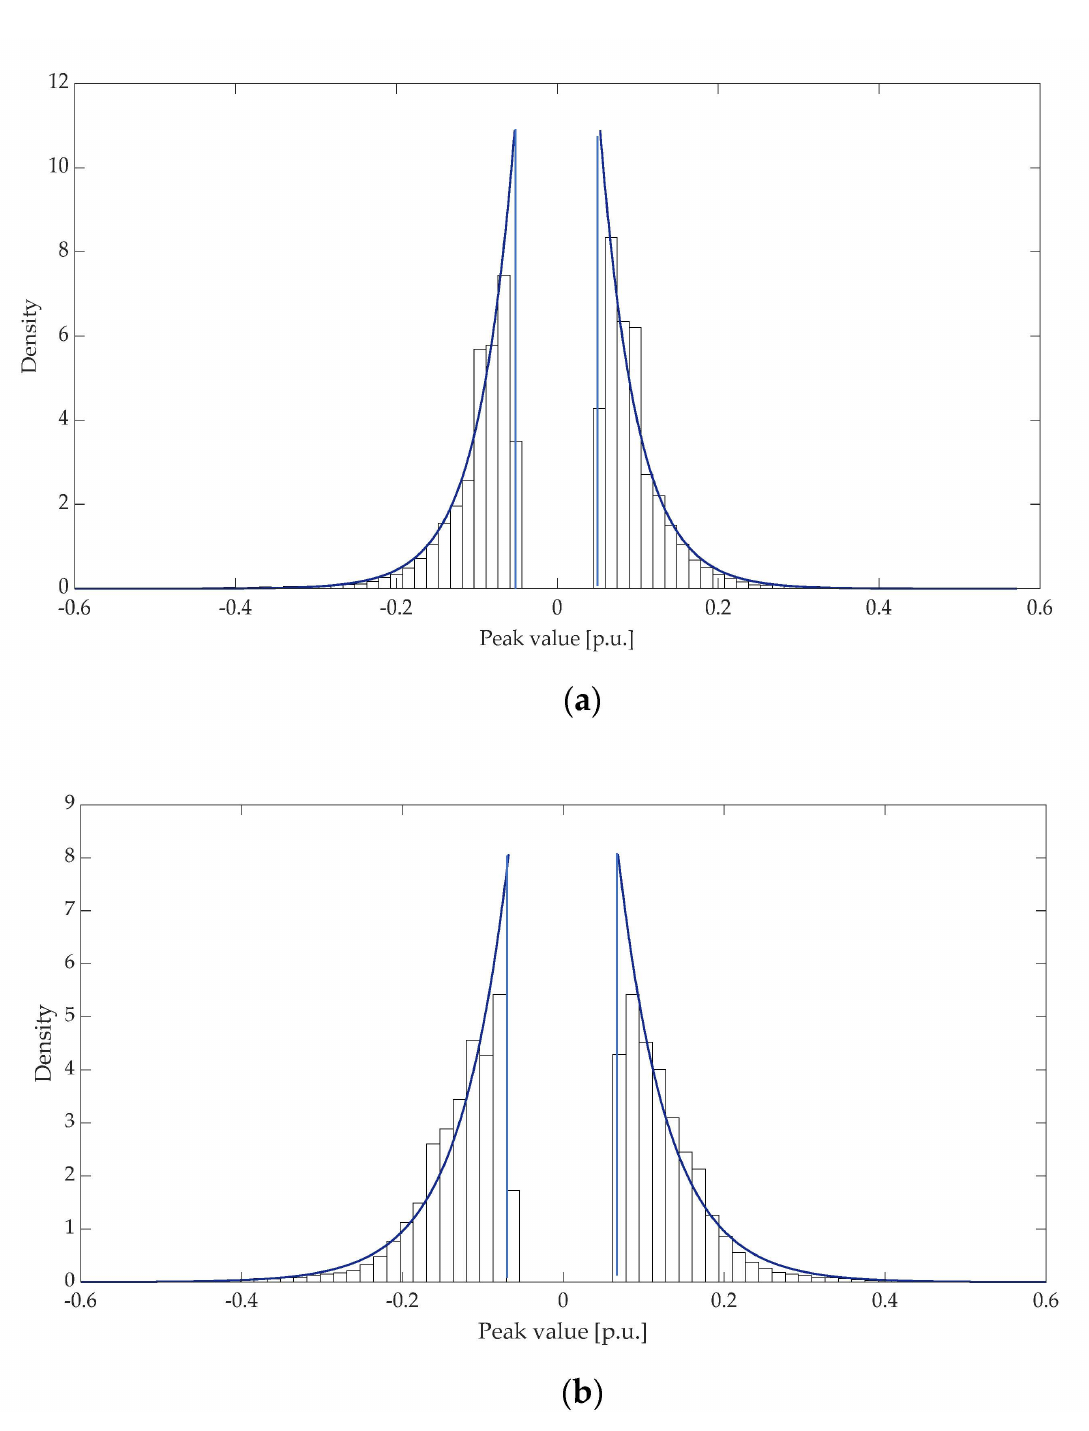
Figure 16. Approximation of the power peak values of the regulation power to a Laplace pdf in Case 2 ( a ) and Case 3 ( b